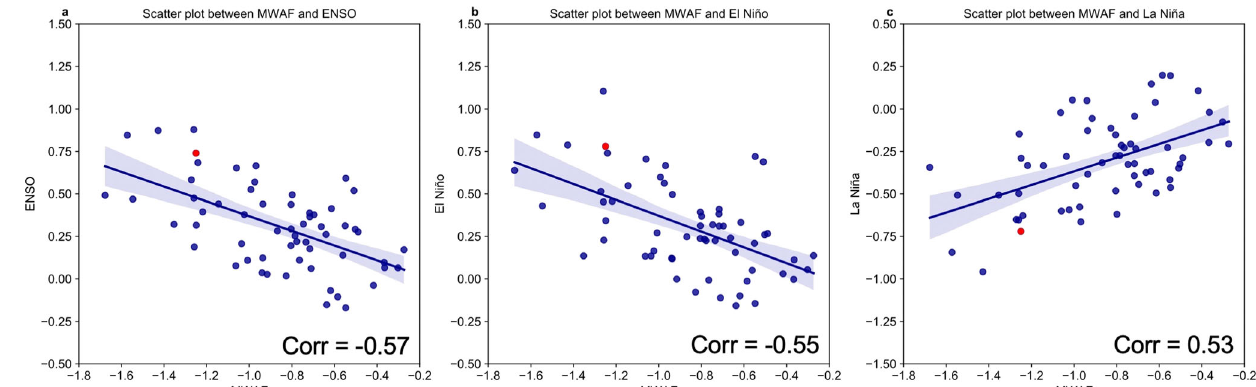
Fig. 8 Intermodel relationship between Niño3.4 index and MWAF for selected NPO events. a Scatter plot between D0JFM1 MWAF for NPO events and D1JF2 SST anomalies over Niño3.4 (5°S – 5°N, 120°W – 170°W) region presented for the difference between positive and negative NPO phases. b Same as ( a ) but only for all positive NPO phases. c The same as ( b ) but for all negative NPO phases. The red dots show the observations while the blue dots represent the CMIP5/6 models. Linear regression lines are shown with their 90% con fi dence intervals (shaded) using the bootstrap method.